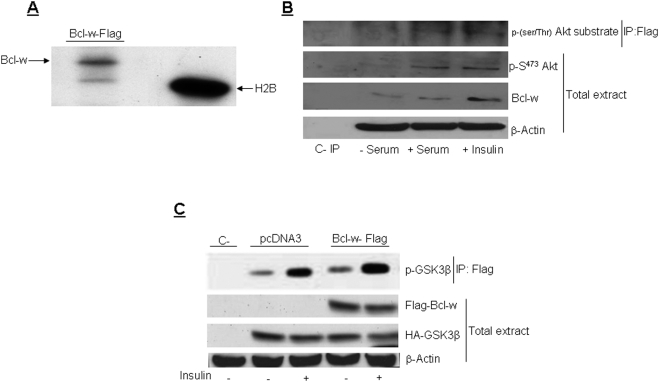
Akt phosphorylates Bcl-w in vitro and in vivo.(A) HeLa cells were transfected with 2 µg of DNA of Flag Bcl-w, solubilized, and 1 mg of protein extract was immunoprecipitated with an anti-M2 Flag antibody. Immunoprecipitates were incubated with recombinant constitutive active Akt (rAkt), and in vitro kinase assay was conducted as described in the methods. Samples were loaded onto 2.5% SDS-PAGE and analyzed by autoradiography. As positive control we used Histone2B (H2B). (B) HeLa Bcl-w stable expressing clones were serum starved for 18 hrs and then stimulated with 100 nM insulin or with 20% serum for 15 min as indicated. Cells were solubilized and immunoprecipitated with an anti-M2 Flag antibody. Immunoprecipitates were loaded onto SDS-PAGE and blotted with an anti-phospho Akt substrate antibody that recognizes all the phosphorylated Akt substrates. Total extracts were analyzed by western blot using the indicated antibodies. (C) HeLa cells were transfected with 2 µg of pcDNA3 empty vector or 2 µg of HA-GSK3β, and 2 µg of Flag-Bcl-w for 48 hrs. Cells were stimulated with 100 nM insulin for 15 min, solubilized, immunoprecipitated using an anti-HA antibody, and analyzed by western blot using an anti-phospho-Gsk3 antibody. Total extracts were analyzed by western blot using the indicated antibodies. Bcl-w overexpression does not affect Akt activity.